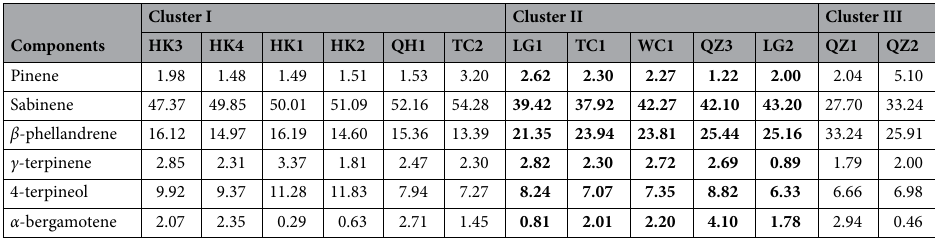
Table 3. Variations in some important volatile components (%) of EOs of C. lansium seeds in the three